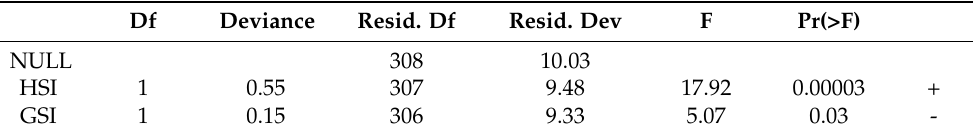
Table 1. Generalised linear models performed on fullness values of female Solea solea specimens captured from January to December 2019 in the Central Adriatic Sea for a study of their diet. +/ − : sign of the correlation. HSI and GSI are hepatosomatic and gonadosomatic indices, respectively. AIC: Akaike’s information criterion.